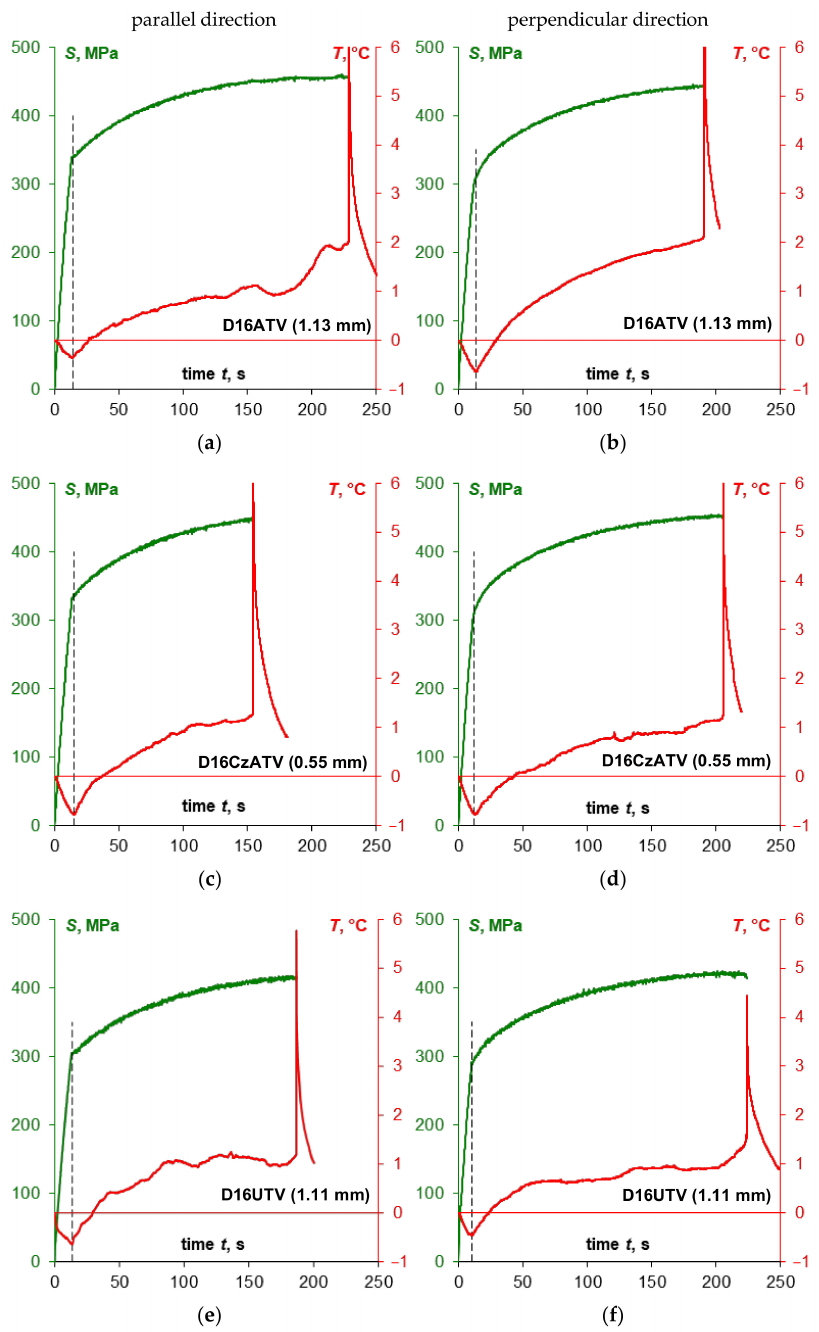
Figure 12. The summary of stress S and temperature T change curves obtained during monotonic tensile tests of specimens made of D16ATV sheet plate ( a , b ), D16CzATV sheet plate ( c , d ) and D16UTV sheet plate ( e , f ) depending on the specimen cutting direction in relation to the sheet plate rolling di-